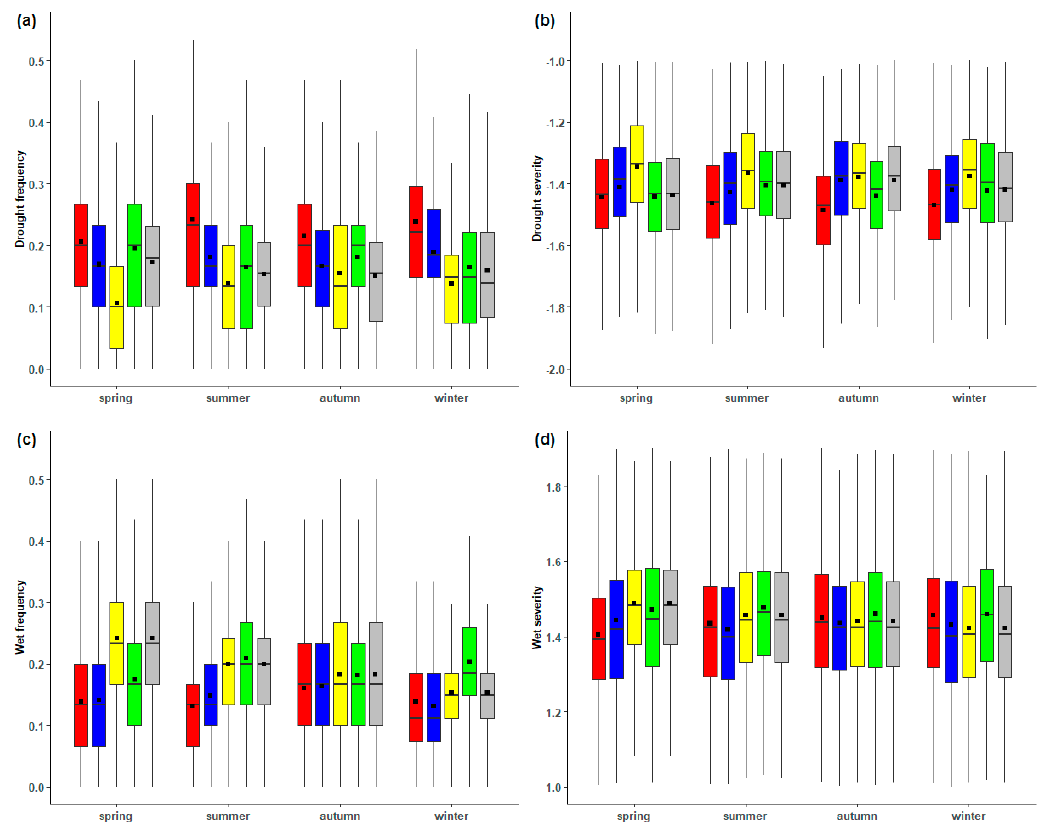
Figure 8. Temporal variation of seasonal drought and wet frequency ( a , c ) and intensity ( b , d ) over China for the periods 1965–1974 (decade1), 1975–1984 (decade2), 1985–1994 (decade3), 1995–2004 (decade4), and 2005–2017 (decade5), respectively. For each box, the central black line is the median, the black square point is the average, the upper and bottom edge of the box correspond to the 25th and 75th percentiles, and the whiskers show the range of the data.